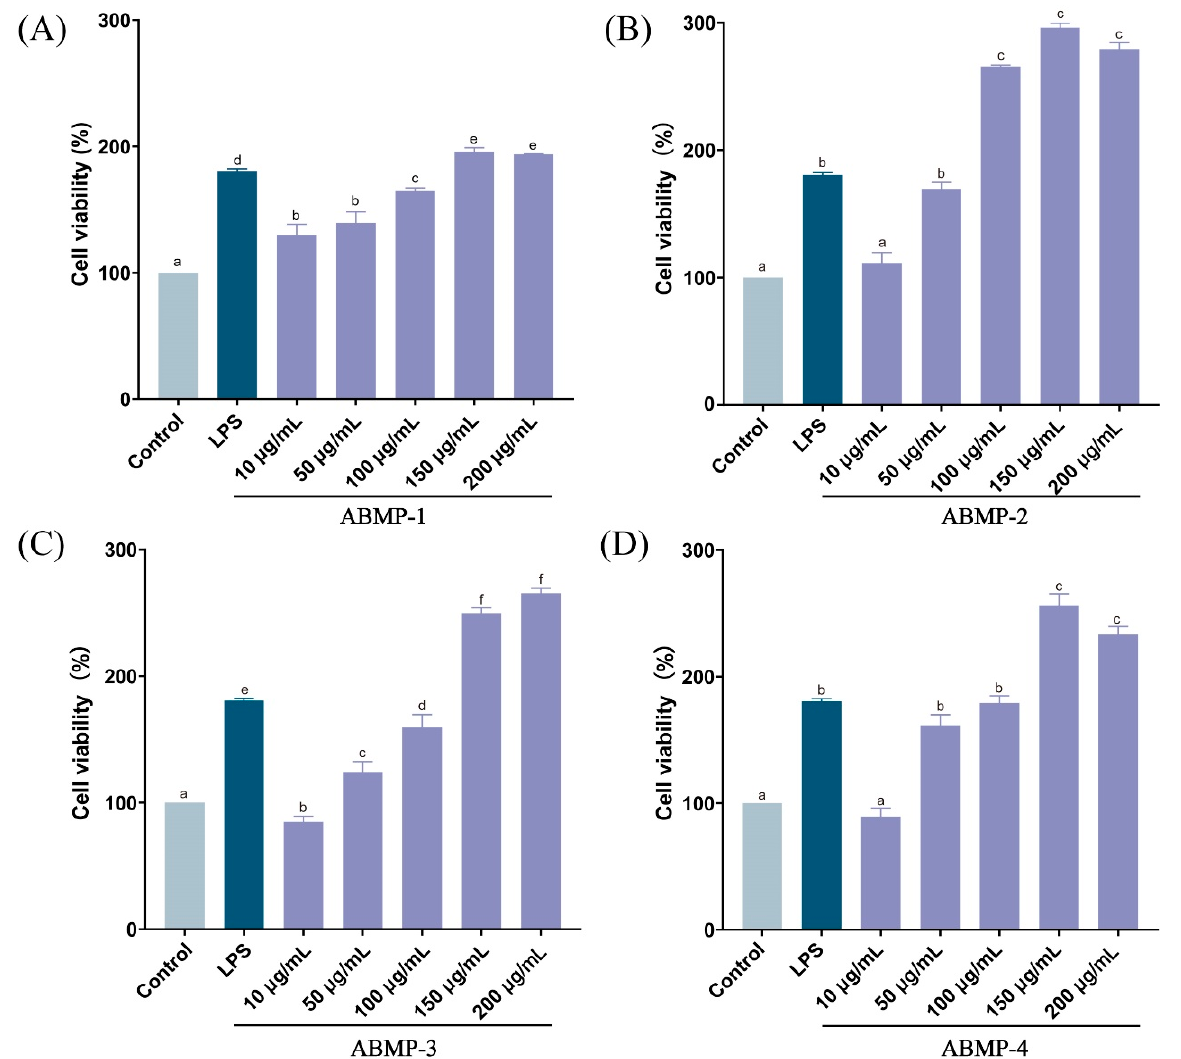
Figure 4. Effects of different fractions of ABMP on RAW264.7 cell viabilities. ( A ) ABMP-1; ( B ) ABMP-2; ( C ) ABMP-3; ( D ) ABMP-4. Mean values marked with different letters (a, b, c, d, etc.) were significantly different ( p < 0.05).